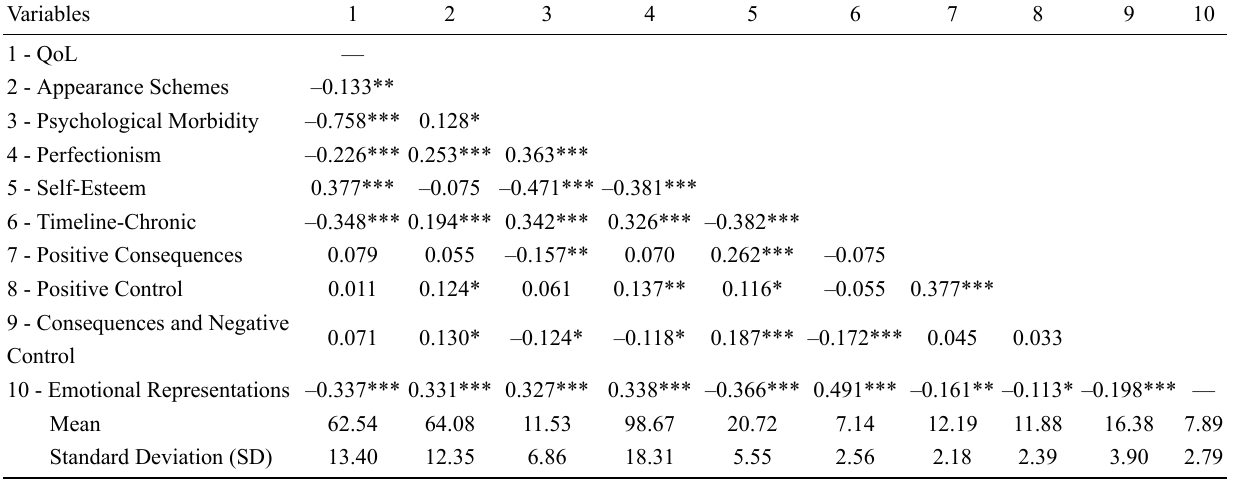
Table 2. Relationship between psychological variables and